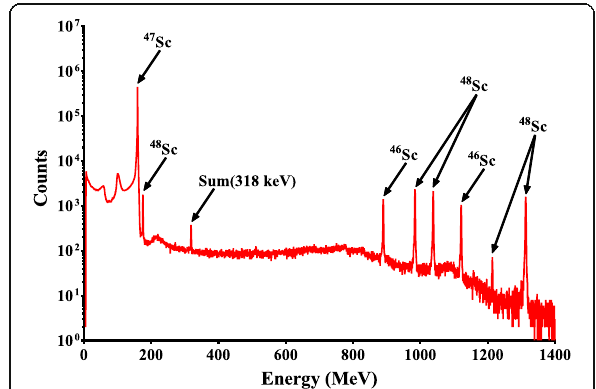
Fig. 4 HPGe spectra of the purified radiolabeling solution. The photopeaks attributed to 46,47,48 Sc have been characterized and labeled. The sum peak due to the intense 47 Sc photopeak at 159 keV has been noted